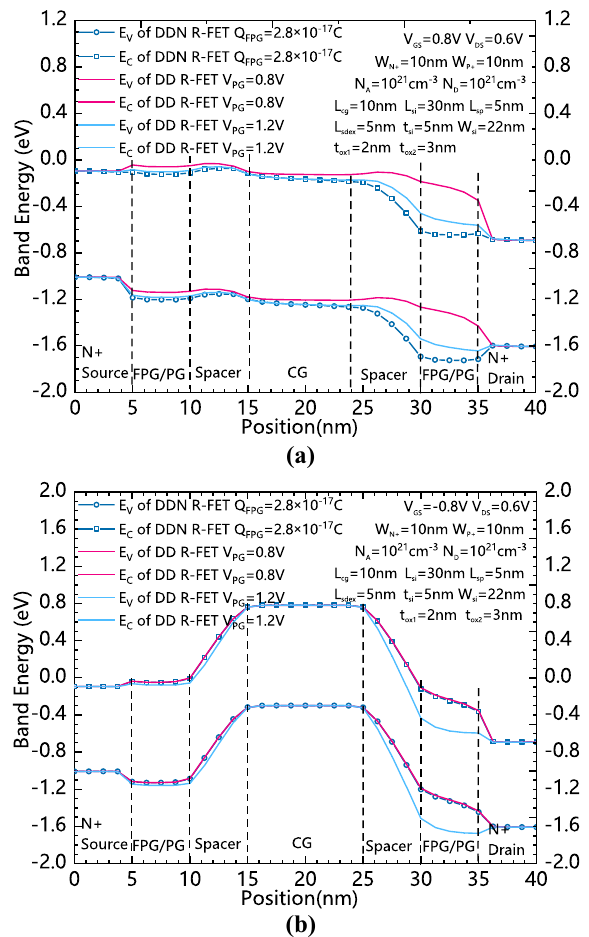
Figure 4. ( a ) Comparison of Energy band diagram between DDN R-FET and DD R-FET with positively charged FPGs and forwardly biased CG. ( b ) Comparison of Energy band diagram between DDN R-FET and DD R-FET with positively charged FPGs and reversely biased